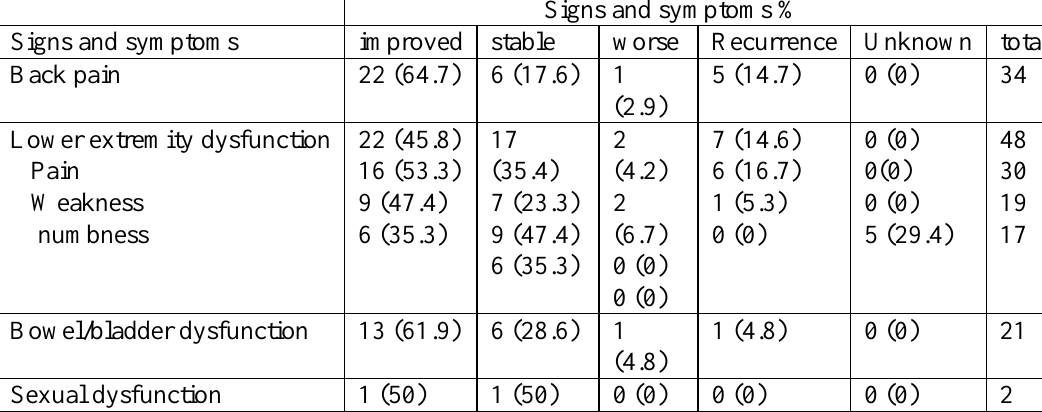
Signs and symptoms %